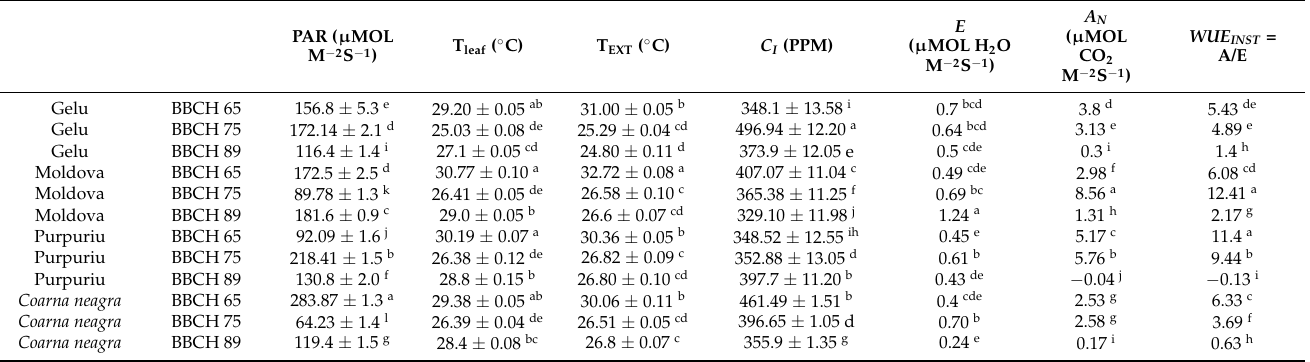
Table 5. The dynamic evolution of main photosynthetic parameters in the studied growth phases for the four analyzed varieties in the second